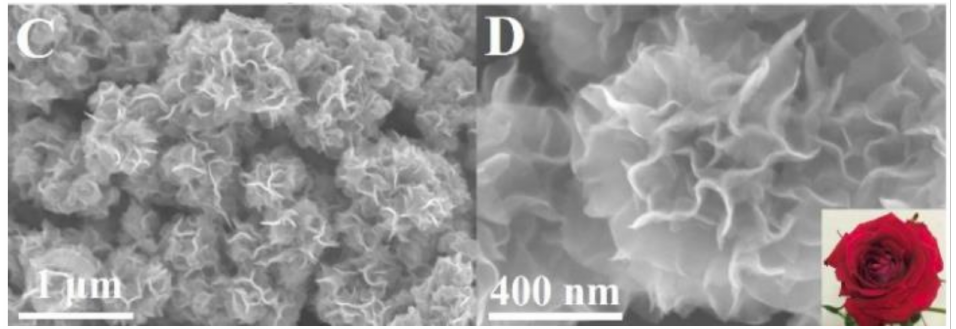
Figure 9. Low- ( C ) and high-magnification ( D ) SEM images of rhodium nanoroses, reprinted with permission of Elsevier [204].